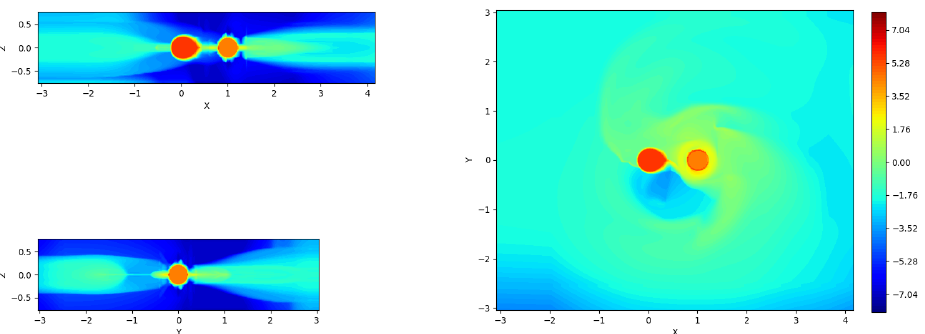
Figure 7. The 3D hydrodynamic simulation of the mass transfer in the oEA star RZ Cas in the XYZ coordinate system where the origin of the Z-axis is located at the center of the Roche-lobe-filling star and the X- and Y-axes lie in the orbital plane. The right panel shows the X-Y and the left panel the X-Z and Y-Z cross-sections of the density distribution. The density scale is logarithmic in units of 10 − 11 particles per cubic centimeter. The mass transfer generates the circumprimary and circumbinary gas flows forming the quasi-disc in the orbital plane, with an inhomogeneous density that depends on the mass transfer